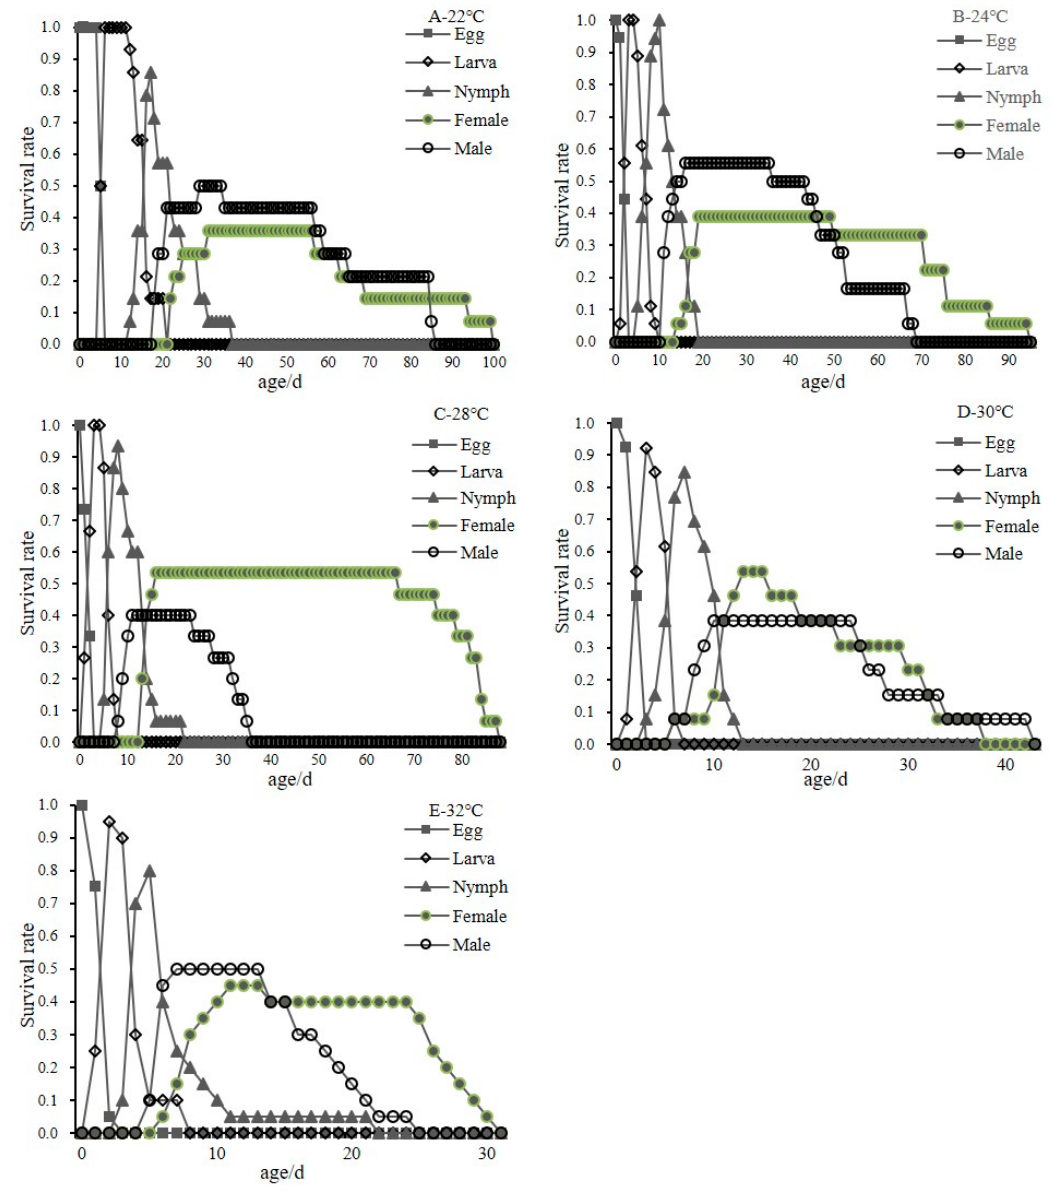
Figure 3. Age-stage specific survival rate ( S xj ) of C. malaccensis at di ff erent temperatures (A-E are 22, 24, 28, 30 and 32 ◦ C, respectively)